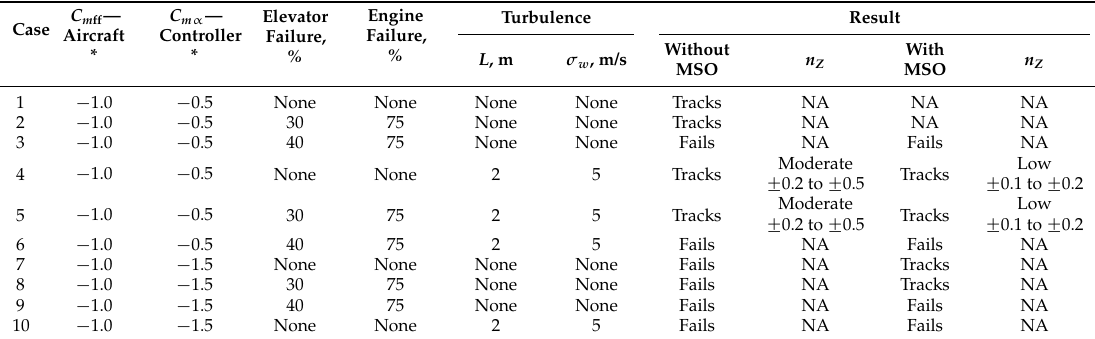
Table 5. Simulation results—modeling error in controller.